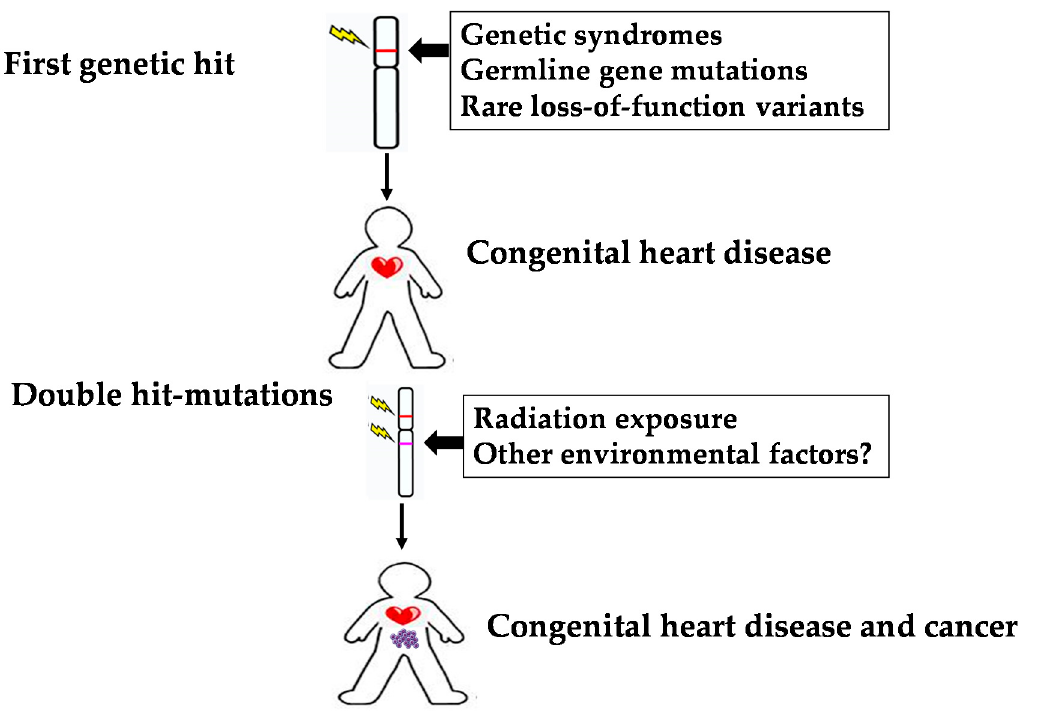
Figure 2. Illustration of unifying model for understanding the relationship between CHD, radiation exposure, and cancer. This model supports the notion that germline variations in CHD increase the susceptibility of induced DNA mutations.